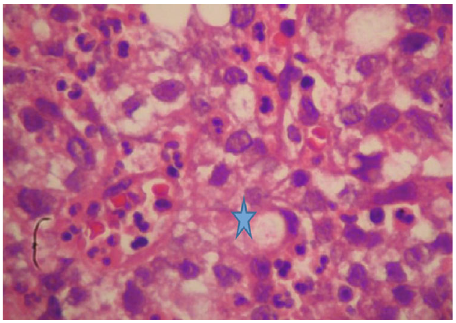
Figure 4: Signet-ring cells in the poorly di ff erentiated adenocarcinoma (H&E, ×